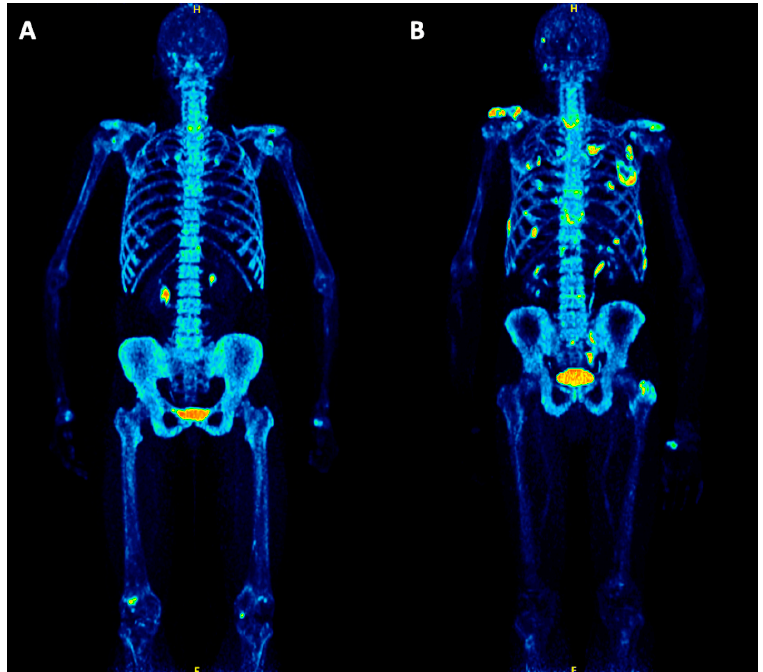
Figure 1. Maximum intensity projection (MIP) PET/CT images of two symptomatic multiple myeloma (MM) patients before treatment. ( A ) PET/CT of a 66 ‐ year ‐ old female patient shows no 18 F ‐ NaF positive, skeletal myeloma lesions. However, several degenerative changes are depicted, for example in the spine, shoulders, hands and knees. ( B ) PET/CT of a 60 ‐ year ‐ old male patient demonstrating multiple focal, 18 F ‐ NaF positive myeloma lesions in the scapula, humerus, spine, pelvis, femur and ribs, partially corresponding to pathologic rib fractures. Table 2. Descriptive statistics of SUV and kinetic parameters for 18 F ‐ NaF in reference bone and the hottest MM lesions. K 1 and influx (K i ) are expressed in ml min − 1 mL − 1 . k 3 is expressed in min − 1 . SUV values and FD have no unit. Blood volume (V B ), as a fraction, also has no unit.